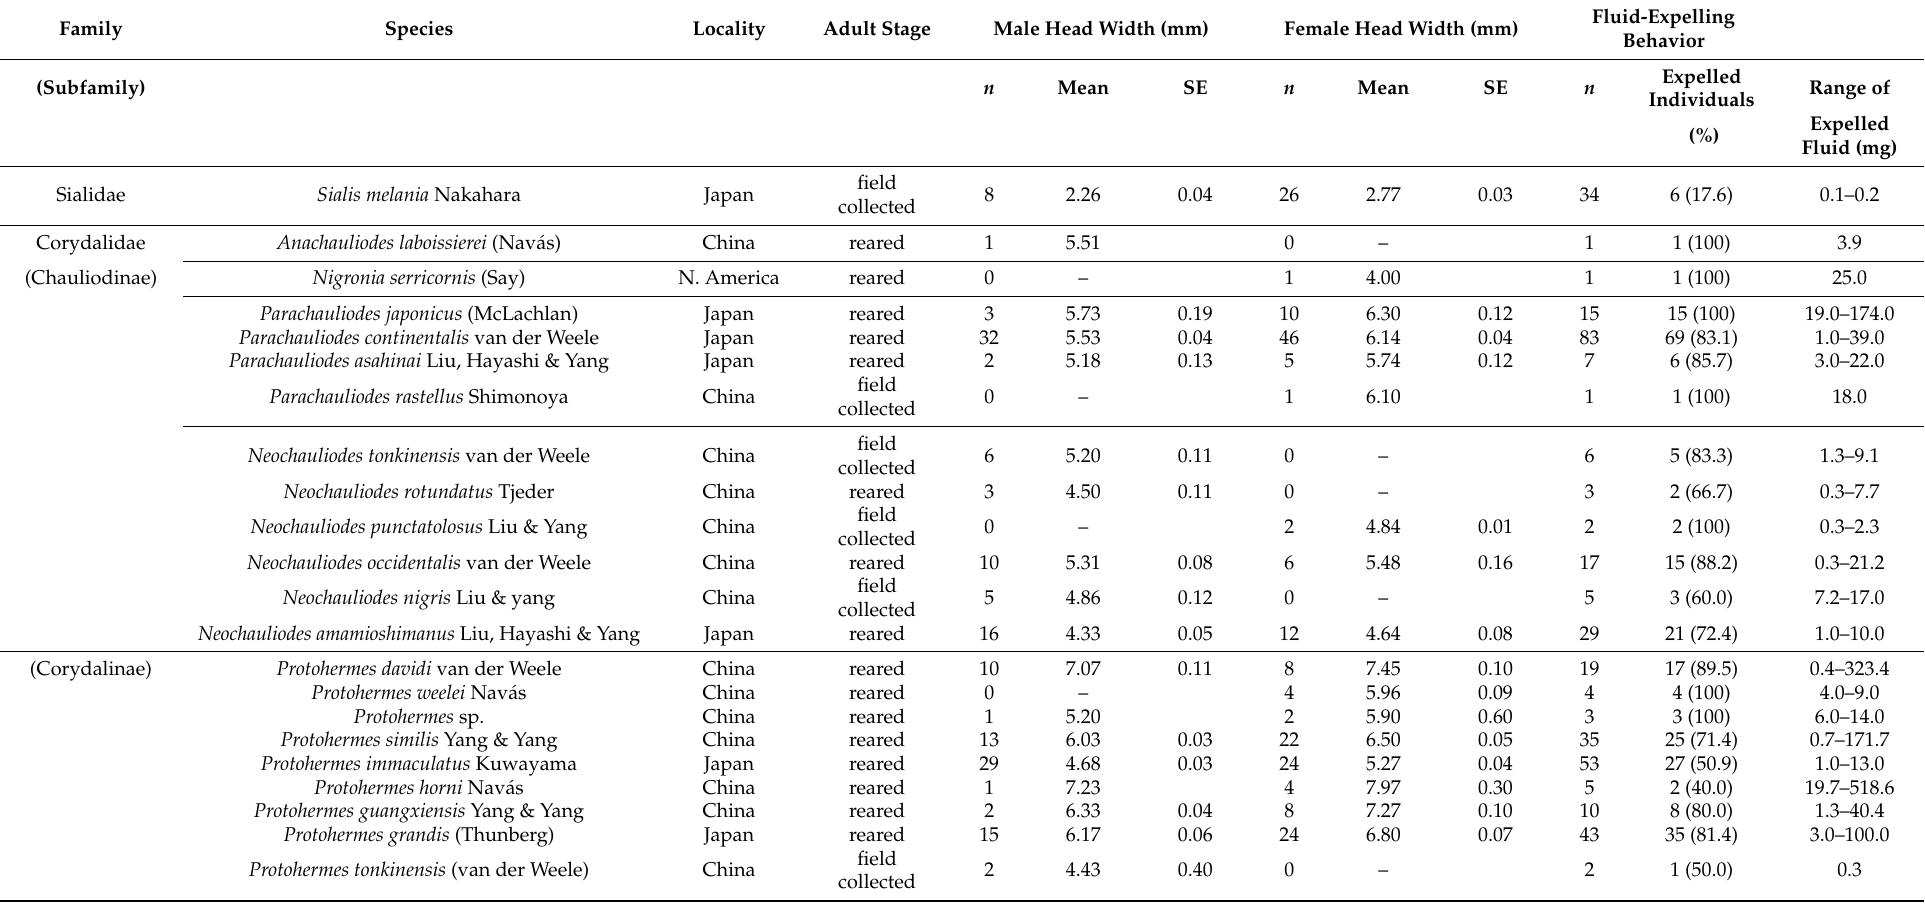
Table 1. Information of localities, adult stages, male and female size (head width), and fluid expelling behaviors in each species of Megaloptera examined in this study. n : number of individuals examined. SE: standard errors, but the range at n = 2. For more information of the amount of fluid expelled by individuals among taxa, see Figure